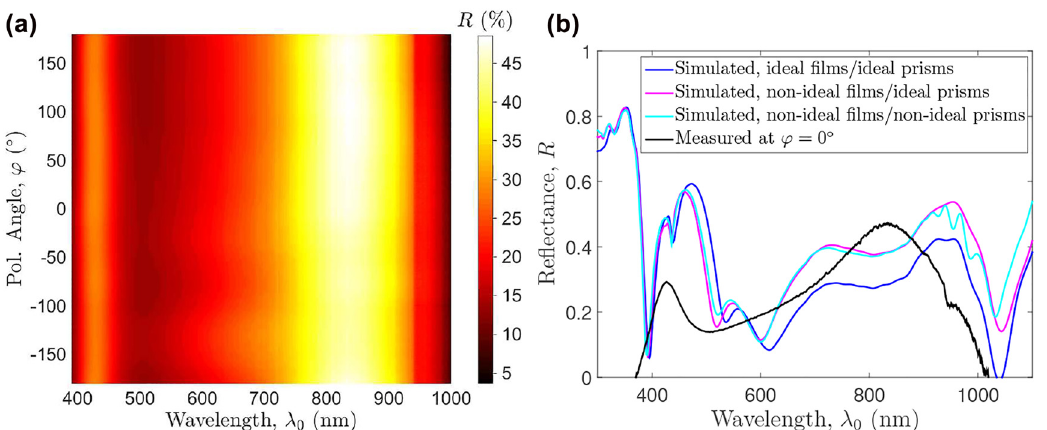
Figure 9: Optical characterization of the fabricated photodetector and comparison with numerical results: (a) the measured reflectance R spectrum within a full range of polarization angle 𝜑 . (b) comparisons of the measured and simulated R spectra, where simulation results of three representative structures are presented: 1. The ideal case described in Table 1, 2) non-ideal film thicknesses ( t nm but ideal square prisms, and 3) non-ideal film thicknesses ( t